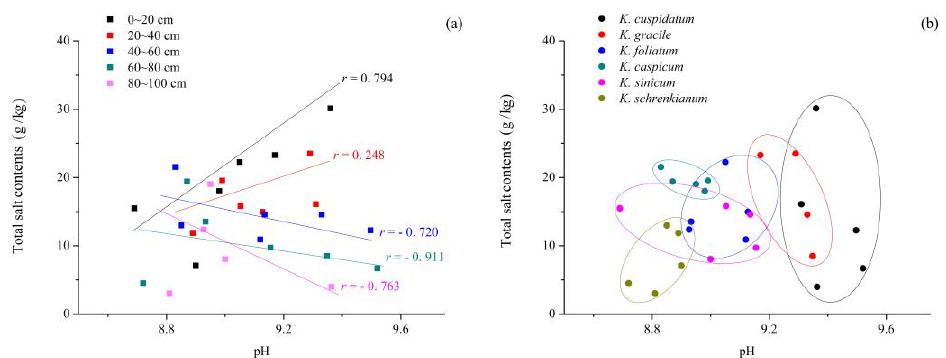
Figure 3. Linear regression plots showing the relationship between total salt contents and pH at indicated depths, and overall, in soil from areas occupied by the six Kalidium species. ( a ) total salt contents at different soil depth; ( b ) total salt contents at different species.